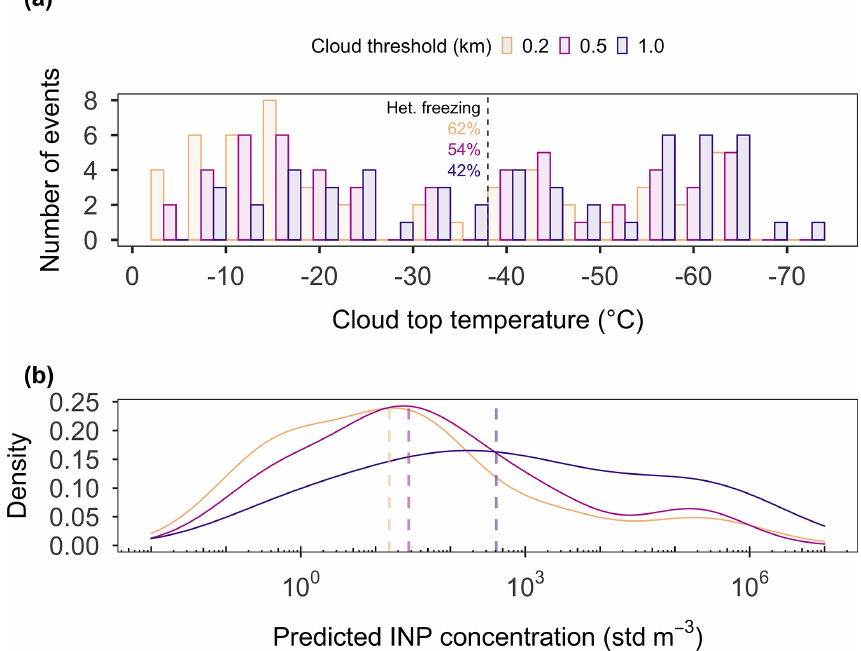
Figure 11. (a) The cloud top temperatures of the highest possible seeder–feeder cloud in 4 ◦ C intervals of the 52 events coinciding with running mean RH ice ≥ 97% throughout the lower 2.7km. The cloud top temperature was derived using the radiosonde measurements which is described in detail in Sect. 3.5. We used the following thresholds for the distance between clouds to be considered as seeder–feeder clouds: ≤ 0 . 2km (orange), ≤ 0 . 5km (pink), and ≤ 1 . 0km (purple). The fraction of events with cloud top temperatures above − 38 ◦ C is given in percent next to the dashed line. This is an estimation of the fraction of events for which the first ice crystals were likely formed via heterogeneous freezing. (b) Density of the INP concentration for the fraction of events with cloud top temperatures above − 38 ◦ C, using the different thresholds to account for seeder–feeder clouds (in colour) as shown in panel (a) . The respective median concentrations are shown by the dashed lines.